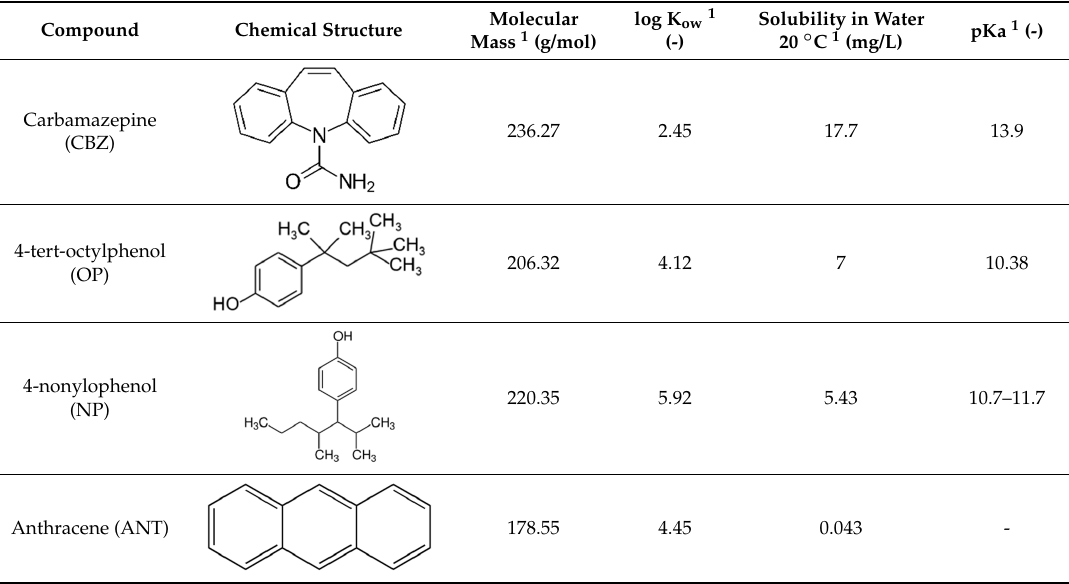
Table 1. Properties of micropollutants.